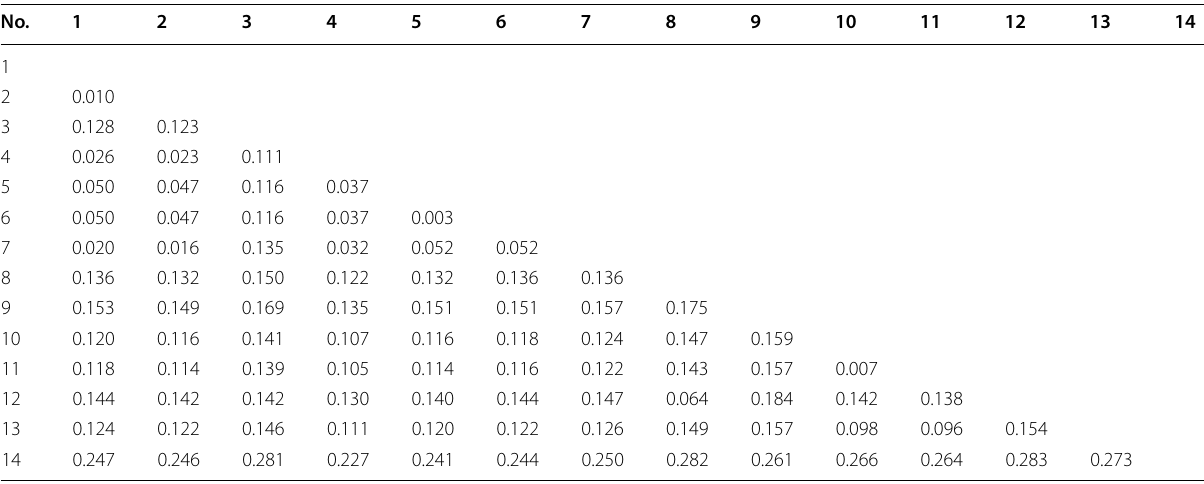
Table 3 Genetic distances of the ITS sequences among Dendrobium species (Nos. 1–13) and Pholidota yunnanensis (No.